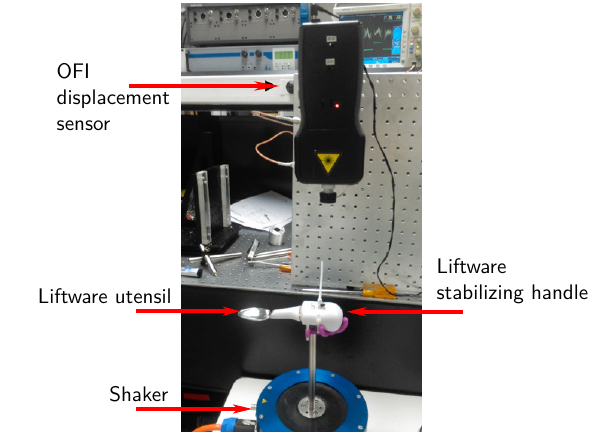
Figure 6. Experimental setup to measure the vibration of the stabilizing handle and the vibration of the utensil attachment.